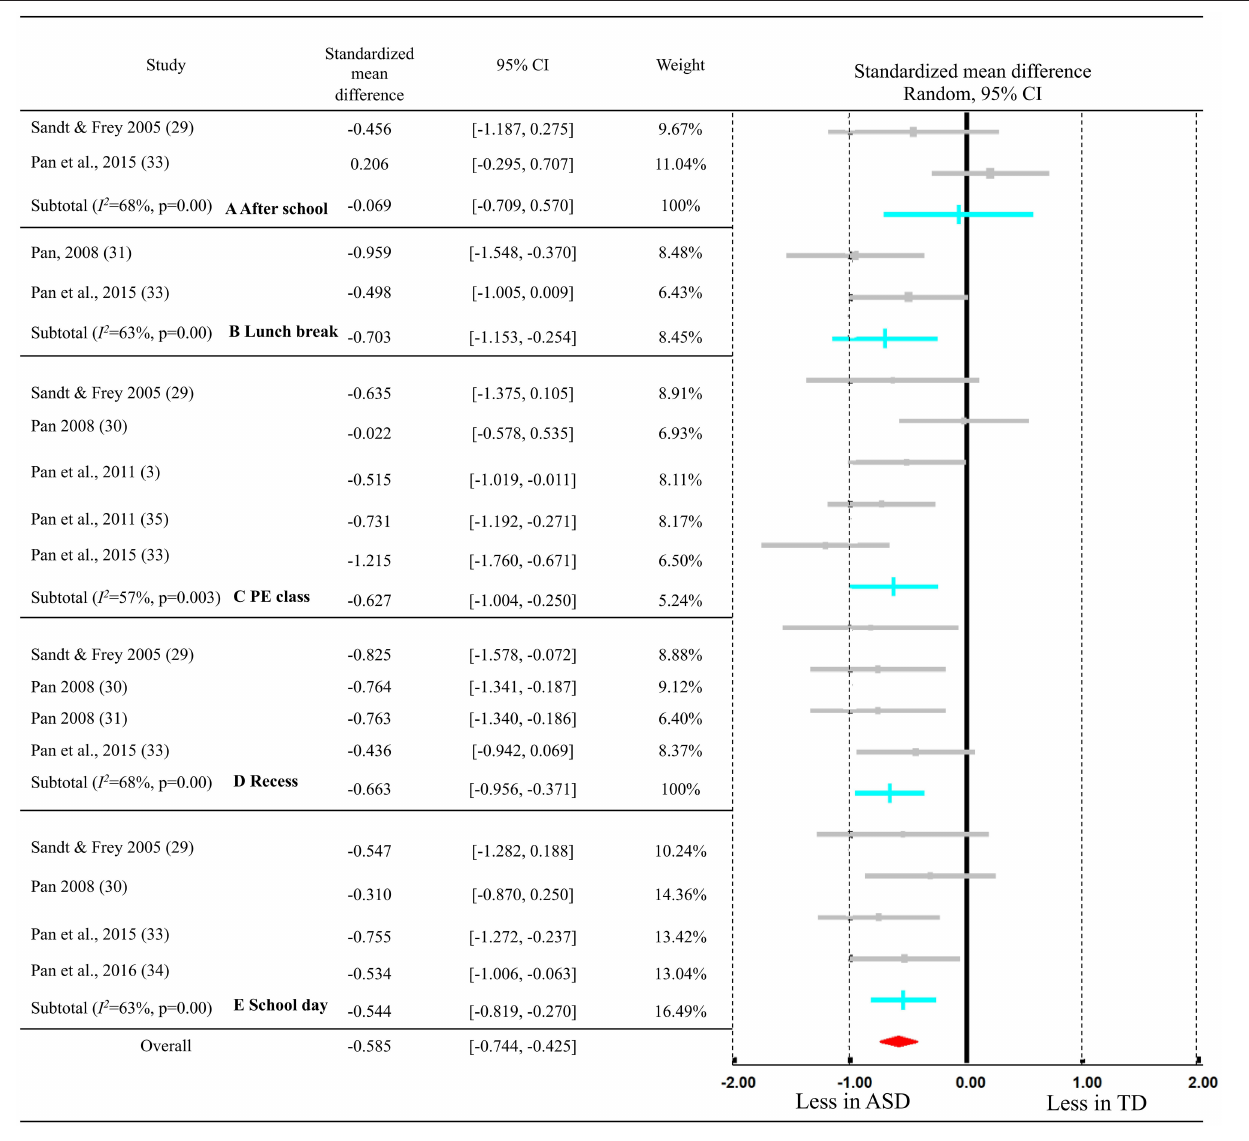
FIGURE 2 | Meta-analysis of difference of the time spent in MVPA between children with ASD and TD after school (A) , during lunch break (B) , at PE class (C) , at recess (D) , and during the school day (E)